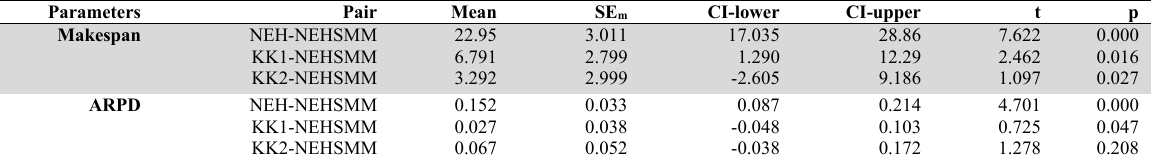
Paired sample t-test results on VRF benchmarks